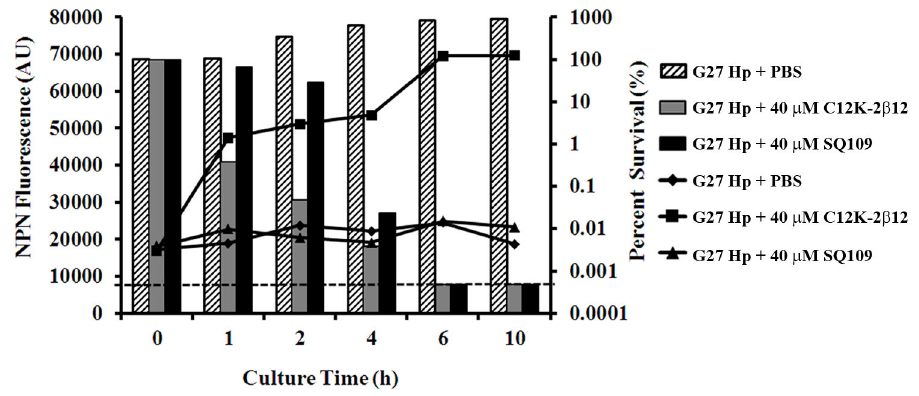
Figure 5. 1-N-phenylnaphthylamine membrane-permeabilization assay demonstrates that SQ109 bactericidal activity is not via membrane lysis. Membrane-permeabilization and bactericidal assays were performed in parallel using H. pylori G27 cultured for 24 hours in the presence of 140 µM SQ109. Membrane permeation and bactericidal activity were monitored by fluorescence increase and by CFU enumeration using the micro-dilution plating method, respectively. Bacterial cells grown in the presence of 40 µM C K-2β or PBS (no drugs) were used as controls. Approximately 5 x 10 6 bacterial cells were sampled at 1 h, 2 h, 4 h, 6 h and 12 12 10 h to determine 1-N-phenylnaphthylamine (NPN) uptake and bactericidal activity. Following excitation (λ = 350 nm) and emission (λ = 420 nm), the NPN fluorescence intensity was recorded in arbitrary units (AU) as a correlate of membrane permeation. Bactericidal activity was expressed as percent survival of starting CFU. The data shown are representative results of three independent experiments. The left axis presents NPN fluorescence depicted by lines while percent survival is shown on the right axis and is indicated by bars. The horizontal dashed line indicates the limit of detection (500